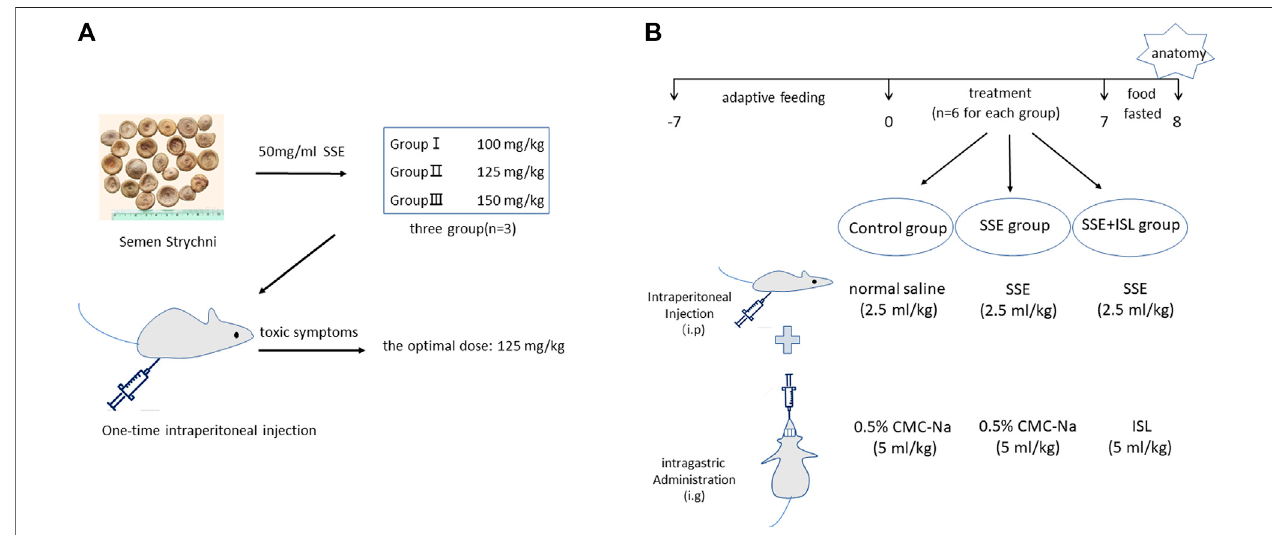
FIGURE 1 | The maximally tolerated dose of rats was determined in pre-experiment (A) . Pre-experiment was employed to determine a dose that can cause poisoningbut isnotlethal. Theanimalswere dividedintothree groups:SSE 100,125, and150 mg/kg,withthreeratsineach group. Theexperimentalwork fl owforSSE intoxication and ISL detoxi fi cation (B)